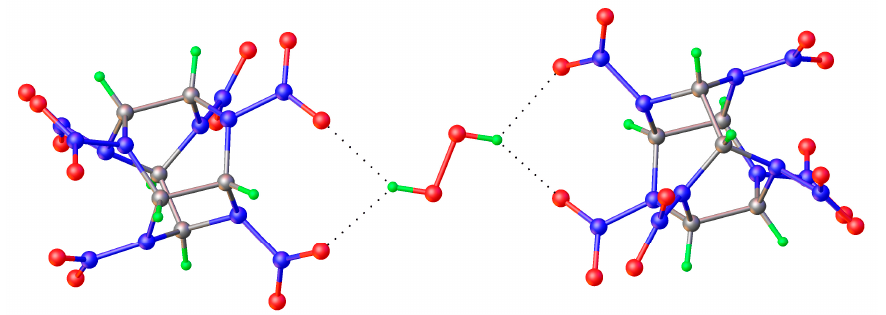
Figure 15. Bifurcate H-bond in 2,4,6,8,10,12-hexanitro-2,4,6,8,10,12-hexaazoisowurtzitane peroxosolvate [84].